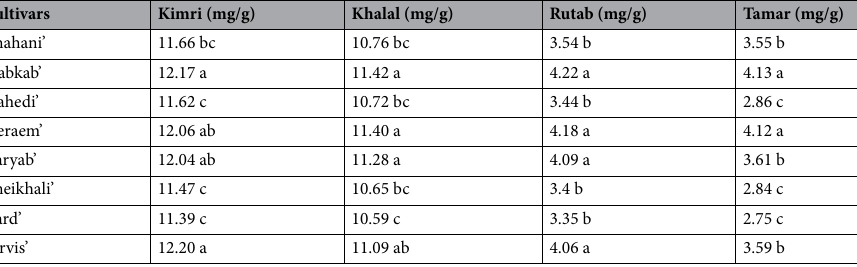
Table 3. The amount of soluble tannin in the fruit of ‘Piarom’ dates in the kimri, khalal, rutab and tamar stages after pollination with eight pollinating cultivars. Different letters within columns indicate significant differences according to Duncan’s multiple range test (p < 0.05).